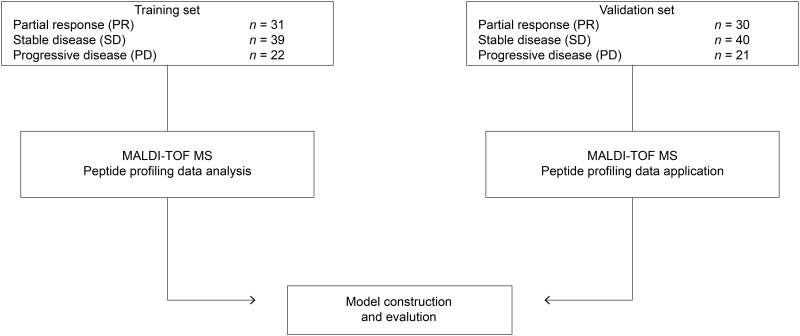
Study overview.This flowchart describes the construction and testing of serum-based predictive peptide models for patients with advanced lung adenocarcinoma who were treated with first-line pemetrexed plus platinum-based chemotherapeutic regimens.